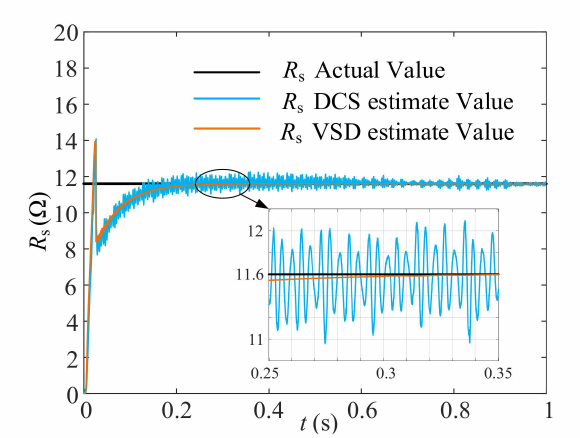
Figure 14. The identified value of stator resistance.